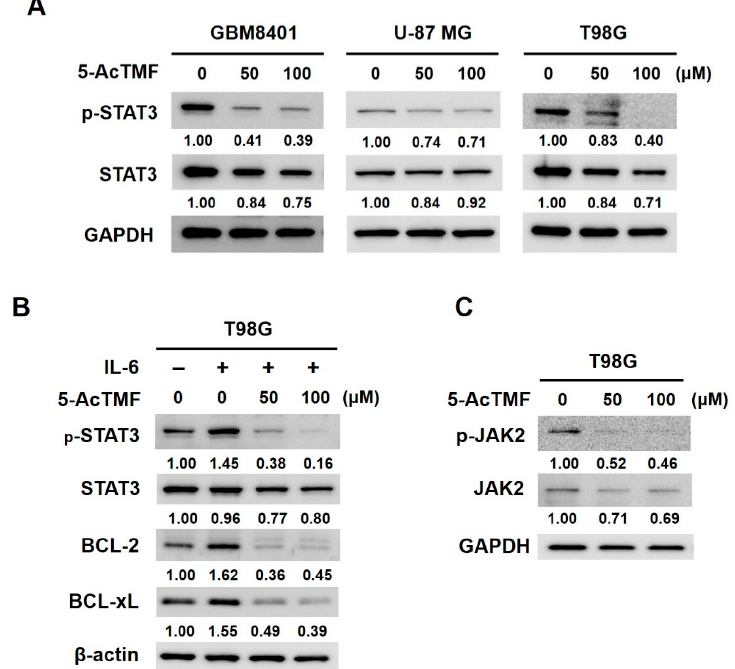
Figure 2. 5-AcTMF suppresses constitutive and inducible activation of STAT3 in GBM cells. ( A ) 5-AcTMF lowers the levels of Tyrosine 705-phosphorylated STAT3 (p-STAT3) levels in GBM cell lines. GBM8401, U-87 MG, and T98G cells were treated with indicated concentrations of 5-AcTMF for 24 h, followed by immunoblotting for the levels of p-STAT3 and total STAT3. ( B ) Blockage of IL-6-induced STAT3 activation in GBM cells by 5-AcTMF. T98G cells were treated with 5-AcTMF for 24 h without or with stimulation by IL-6 (200 ng / mL) for 30 min. The levels of p-STAT3, total STAT3, BCL-2, and BCL-xL were examined by immunoblotting thereafter. ( C ) Inhibition of JAK2 activation by 5-AcTMF. T98G cells after 24 h-treatment with 5-AcTMF were subjected to immunoblotting for the levels of Tyrosine 1007 / 1008-phophorylated JAK2 (p-JAK2) and total JAK2. Either GAPDH or β -actin were used as the control for equal